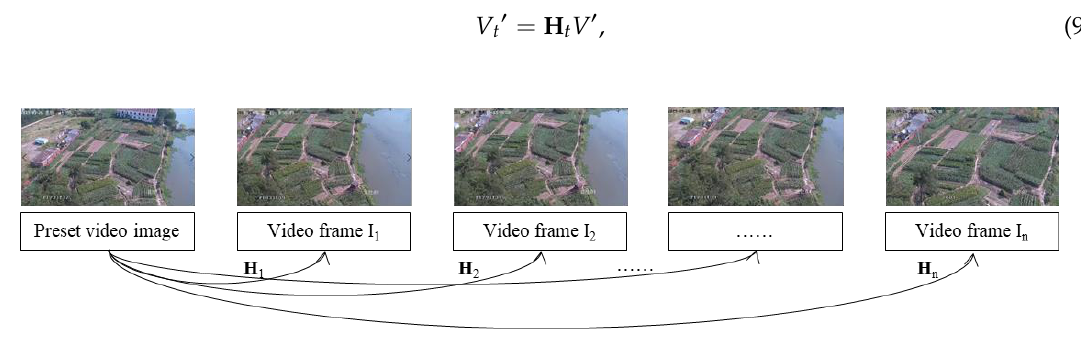
Figure 4. Transformations between video frames and the preset image.